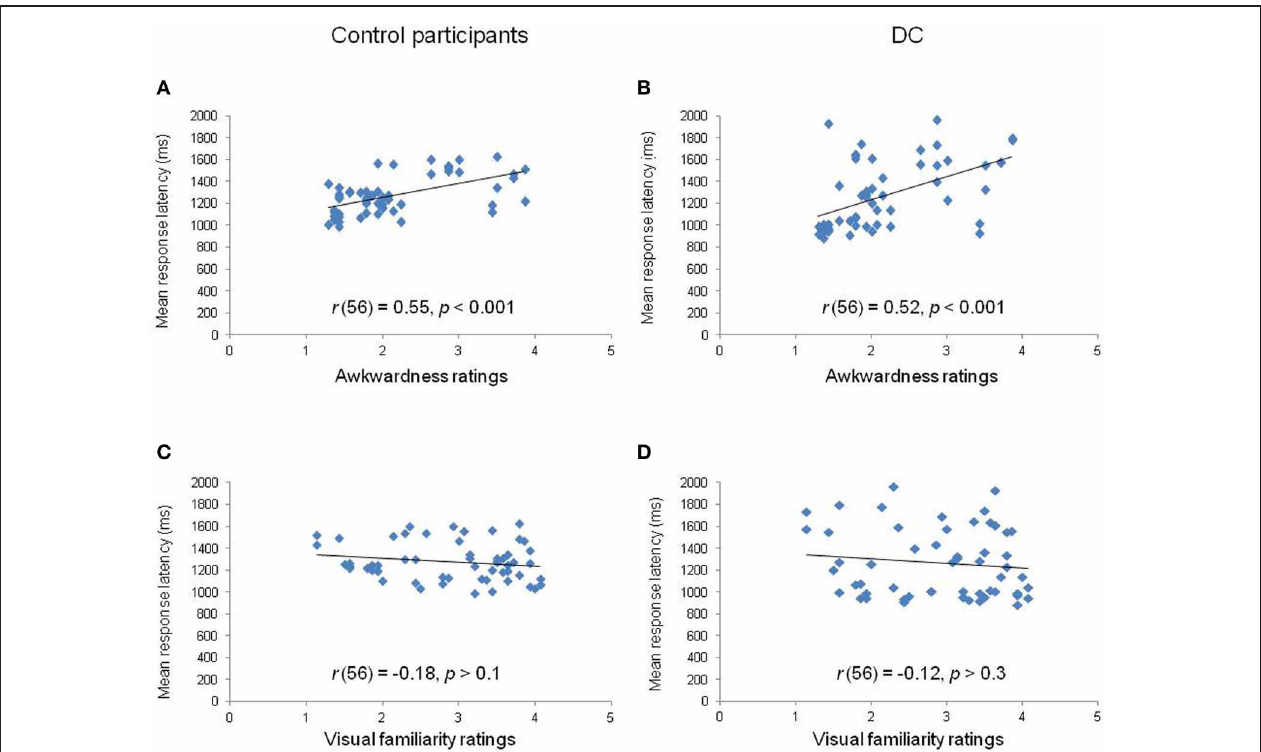
FIGURE 4 | Correlation plots between the mean response latency of controls (left panels) and DC (right panels) for each hand stimulus in relation to rated awkwardness (A,B) and visual familiarity